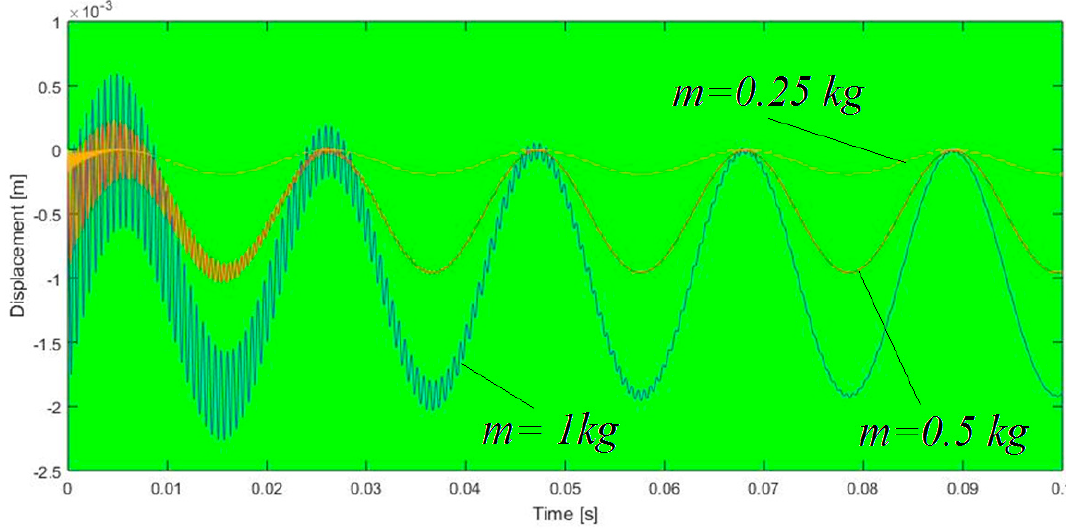
Figure 14. Mass of the bar 1 kg, 0.5 kg, 0.25 kg.